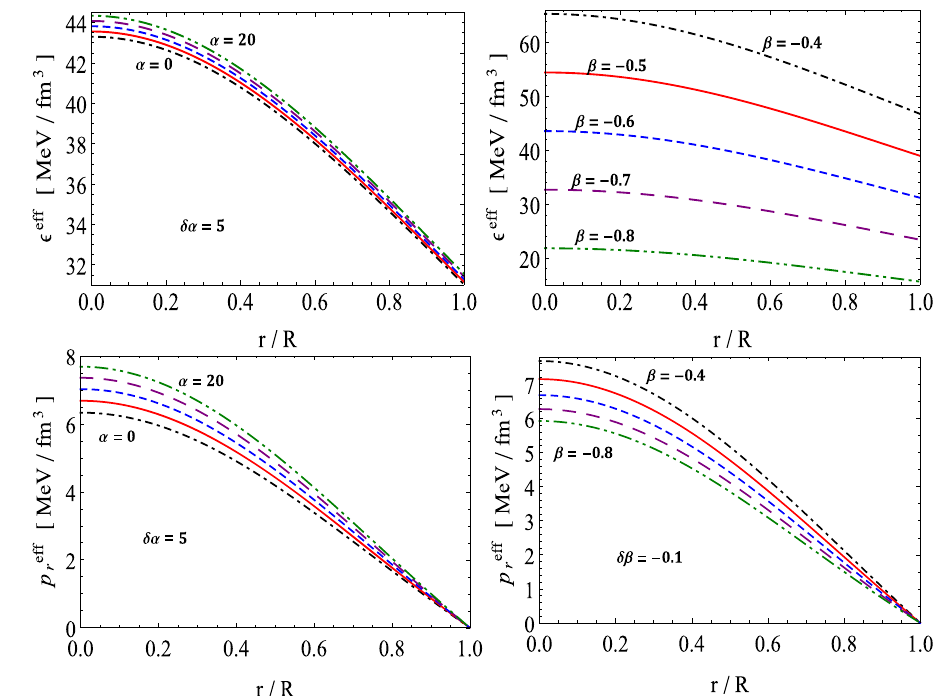
Fig. 2 Variation of effective energy density ( (cid:6) eff ) versus radial coordinate r / R . The left figure is plotted for fixed β = − 0 . 6 with different α while right figure for fixed α = 5 with different β